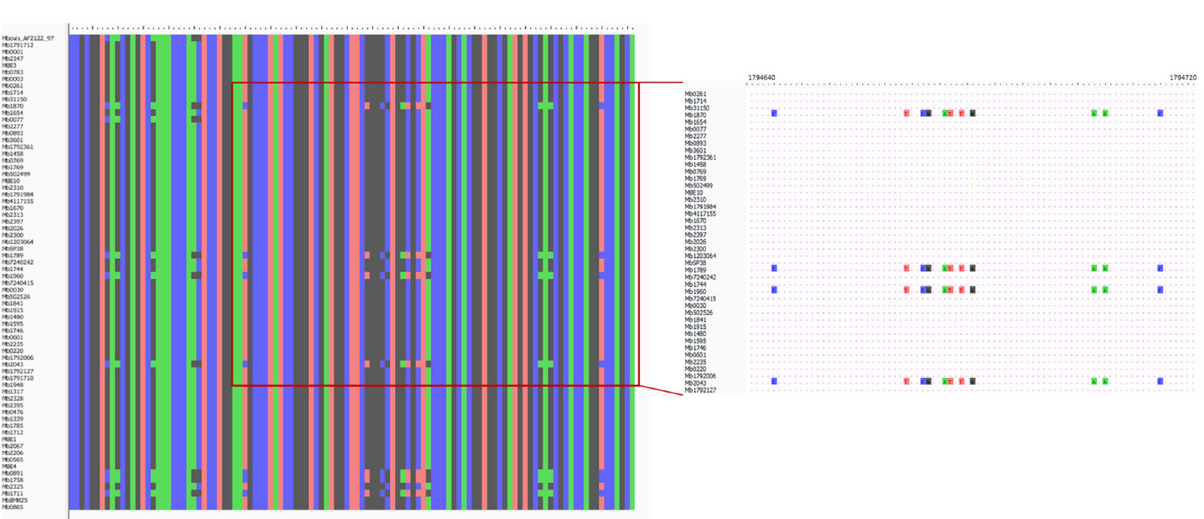
Figure 5. Detailed visualization of alignment in the recombination region of M. bovis dataset affecting the pks12 gene. No gaps or undefined nucleotides were identified in the recombination region of internal nodes. With respect to this event affecting the pks12 gene that encodes a probable polyketide synthase, it encompasses exclusively Eu2 genomes. The quality of sequencing of pks12 was evaluated by read mapping against M. bovis AF2122/97. The SNP positions suggested in the recombination region were confirmed by applying the criteria referred to in the methods section (at least 20 reads and 0.9 frequency of alteration). The polymorphisms were fully confirmed for genomes Mb0891, Mb1711, Mb1789, Mb1870, Mb1758, Mb2043,